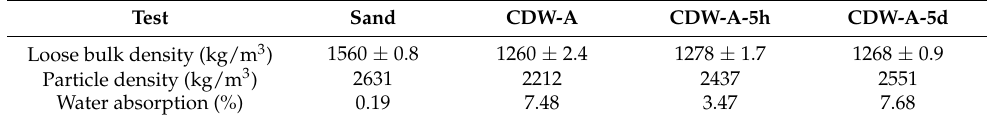
Table 3. Natural aggregates and recycled aggregates’ physical properties.